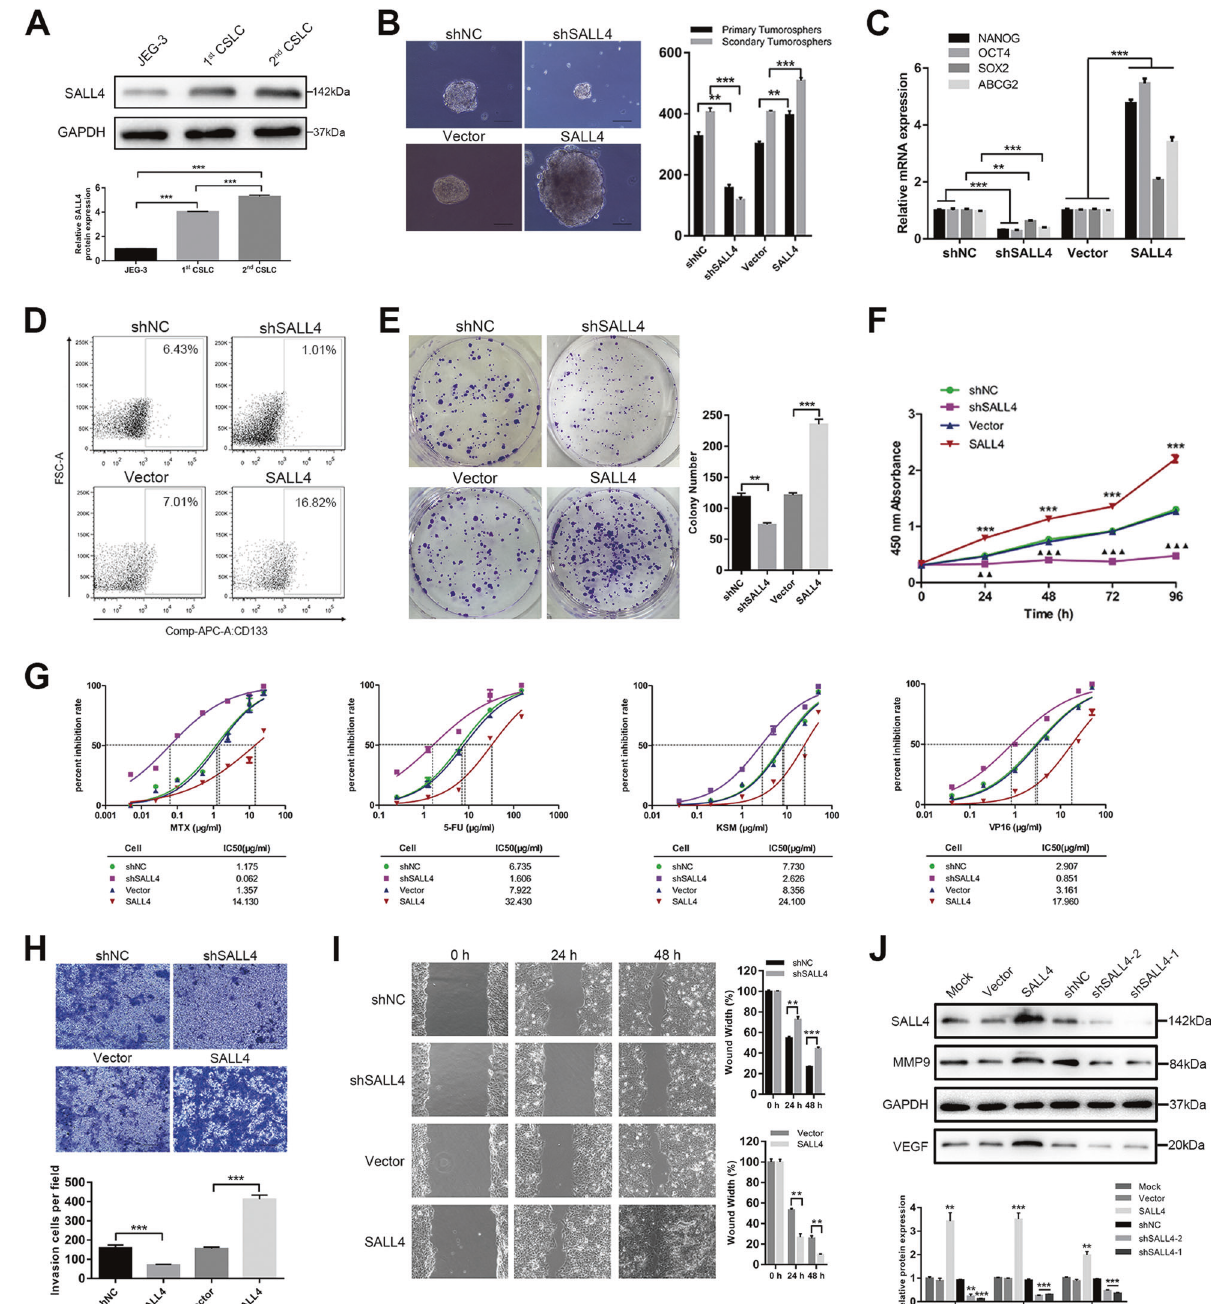
Fig. 2 SALL4 enhances choriocarcinoma CSLC ’ s malignant phenotype. A Western blot analysis of SALL4 protein levels in JEG-3 cells versus CSLCs ’ generations (top) and relative expression compared with JEG-3 cells (bottom). B Representative pictures (left, magni fi cations: ×100) of spheres and counts (right) of two generations. C Stemness gene expression by qRT-PCR analysis. D Flow cytometry plots of CD133 cell-surface protein expression. E Colony-formation assays using single CSLCs (left) and colony number counts (right). F OD values of shSALL4 or SALL4 cells compared with control cells on proliferation ability for 96 h by CCK-8 assay (*SALL4 vs. vector; ▴ shSALL4 vs. shNC). G IC 50 dose response curves of methotrexate, fl uorouracil, dactinomycin, and etoposide. H Representative images (top, magni fi cations: ×100) and quanti fi cation (bottom) of invaded cells using transwell assay. I Migration images (left, magni fi cations: ×100) and quanti fi cation (right) of width area by wound healing assay. J Effects of SALL4 overexpression or silencing on VEGF and MMP-9 protein by western blotting. Data represent mean ± SD from at least three independent experiments. ** P < 0.01, *** P <